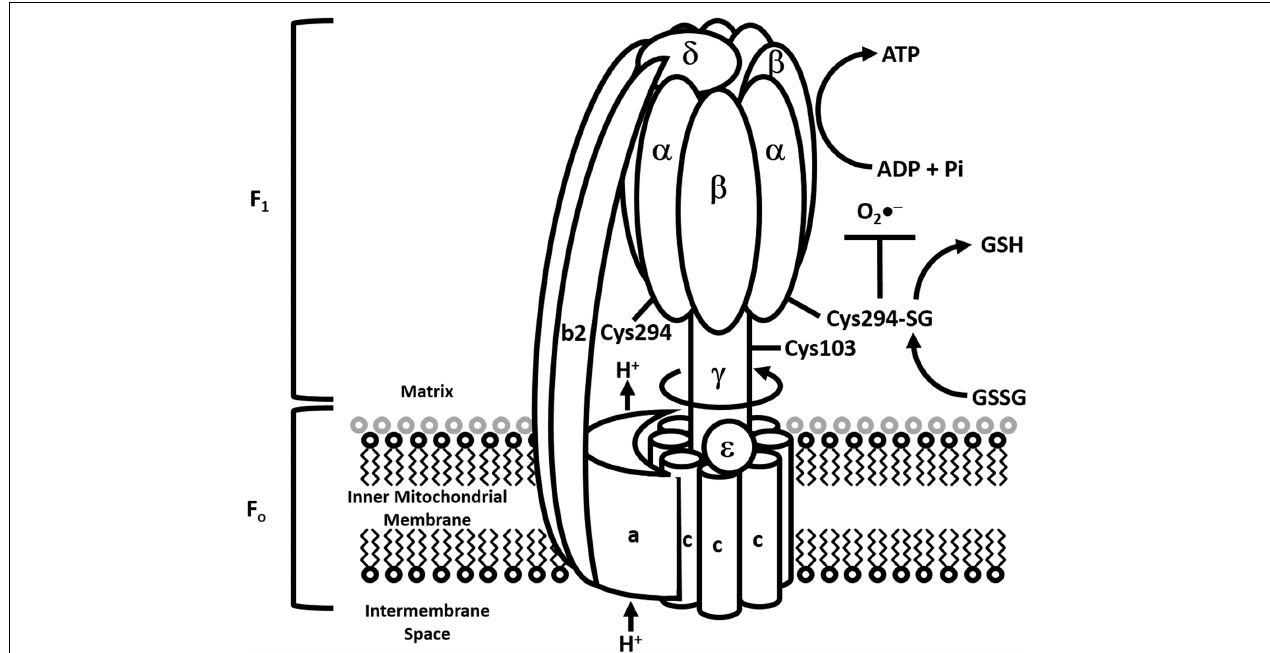
FIGURE 5 | Modulation of ATP synthase by S-glutathionylation. Diagrammatic representation of the ATP synthase complex and how it couples proton transport to the synthesis of ATP. S-glutathionylation of α -subunit in the F 1 portion of the complex is required to modulate ATP